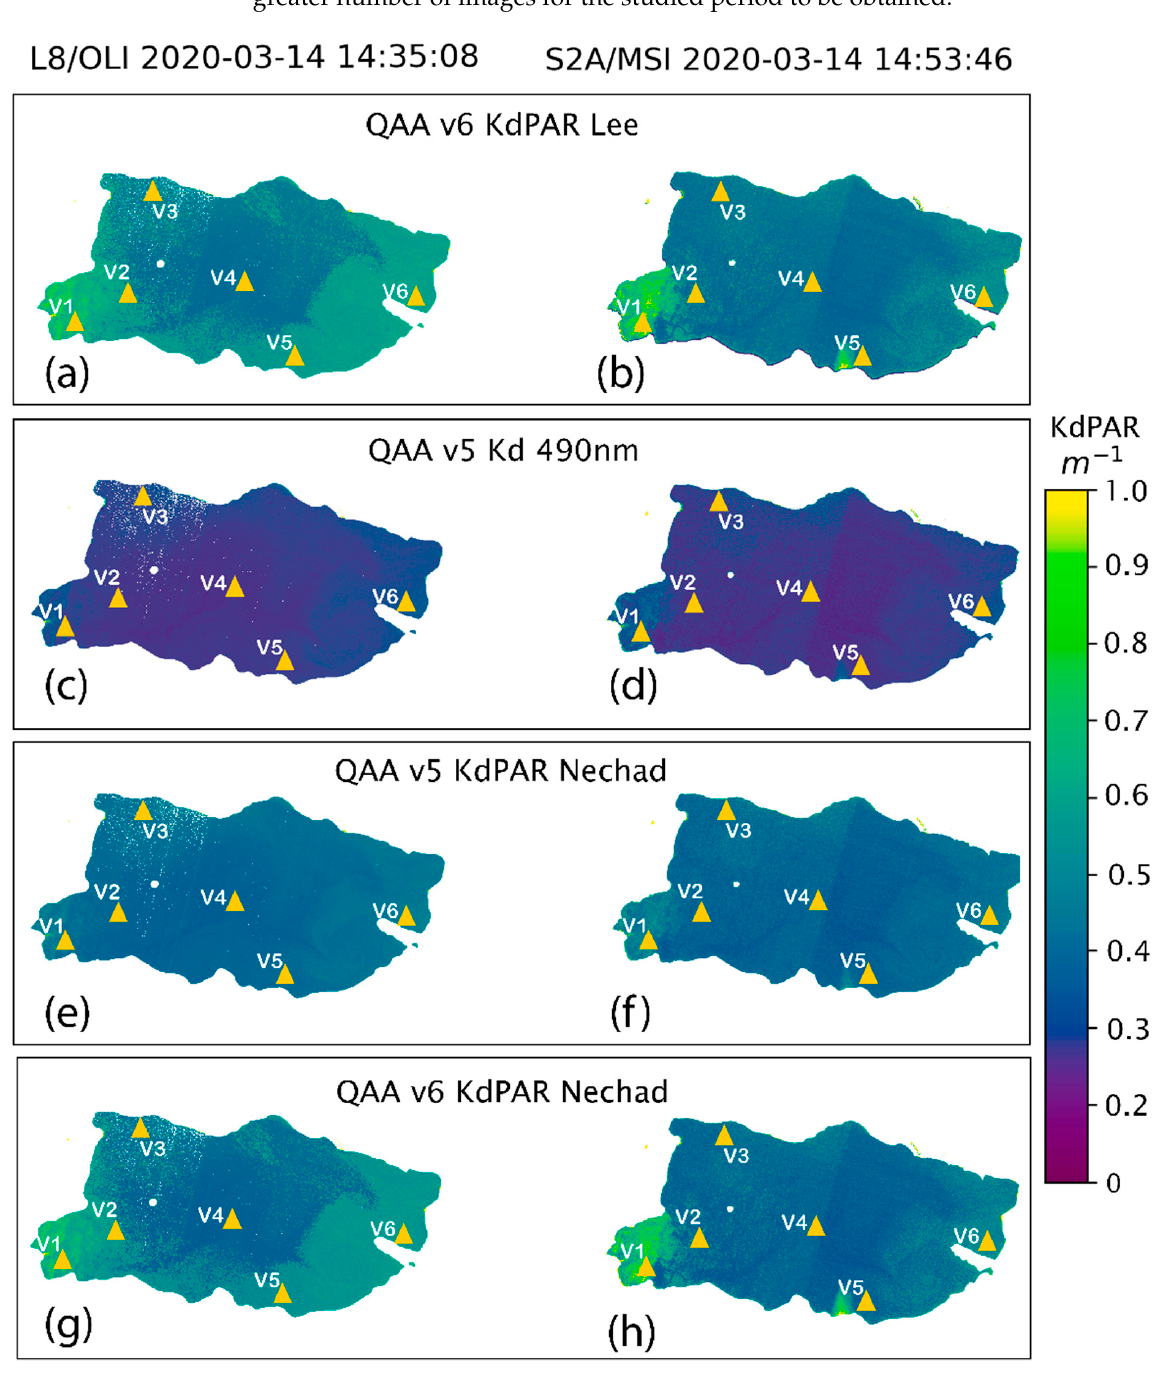
Figure 2. Estimation of KdPAR in Lake Villarrica using four algorithms in ( a , c , e , g ) L8/OLI and ( b , d , f , h ) S2A/MSI images from 14 March